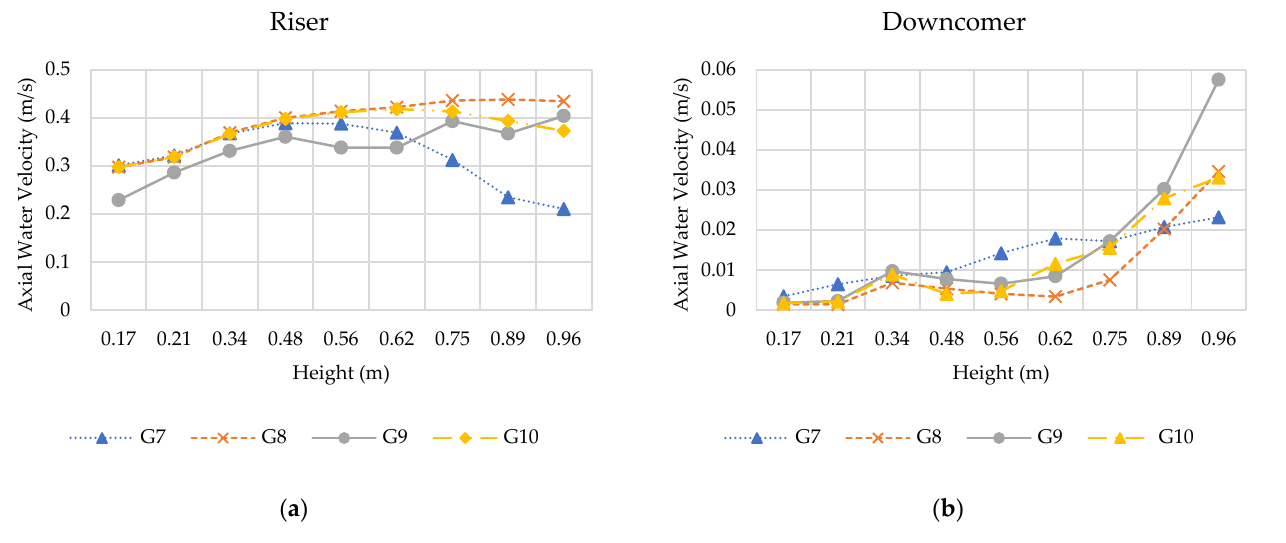
Figure 9. ( a ) Axial velocity in riser of geometries 7, 8, 9 and 10 based on 9 sampling points; ( b ) Axial velocity in riser of geometries 7, 8, 9 and 10 based on 9 sampling points. Figure 10 colors the axial velocity of all ten cases. The comparison is divided as in the previous section, a first comparison of geometries 1 and 2 (Figure 10a), a second of geometries 3–6 (Figure 10b) and, a third of geometries 7–10 (Figure 10c). The riser velocity is represented with the positive values from orange to red, while the downcomer velocity is represented with negative values from green to blue. On geometries 1 and 2 (Figure 10a), it can be seen that the downcomer enters the bottom of the draft tube. This can also be seen on most of the geometries on Figure 10b. This counterflow has been eliminated by transforming the bottom draft tube into a funnel (reducing the diameter of the top part of the draft tube) as shown in Figure 10c.